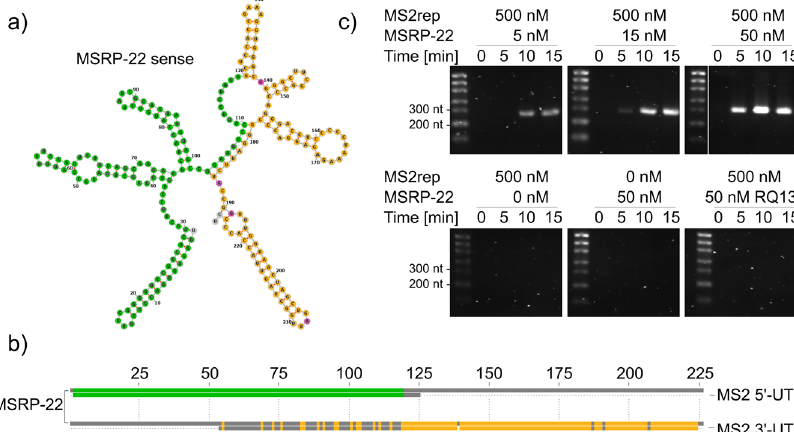
Fig. 6 Properties of a selected small replicating RNA species. a Minimum Free Energy structure of MSRP-22 predicted by RNAfold (default parameters) 60 . Colours indicate sequences aligning to the nucleotides 1 – 118 within the 5 ′ UTR (green) and nucleotides 3464 – 3568 within the 3' UTR (yellow) of MS2wt, respectively. Nucleotides annotated in pink indicate mismatches and grey nucleotides could not be aligned to MS2wt 60,61 . Annotation as sense or antisense strand follows the orientation of the matching MS2 genomic or antigenomic strand, respectively. b Sequence alignments of the isolated MS2 RNA parasite MSRP-22 with the 5 ′ UTR of MS2( + ) (top, green) and 3 ′ UTR of MS2( + ) (bottom, yellow), respectively. Alignments were made with Jalview (Version 2.11.1.3) 62 . c Time-course of replication of MSRP-22, analysed by gel electrophoresis on a 2% TAE agarose gel. Reaction mixtures contained varying concentrations of input MSRP-22 antisense RNA (5, 15 or 50 nM, image cropped) with 500 nM MS2rep core complex (top row). Controls contained either no input RNA, no MS2rep or MS2rep with RQ135 RNA as non-speci fi c RNA input (bottom row). The ladder used was RiboRuler Low Range RNA Ladder (Thermo Fisher Scienti fi